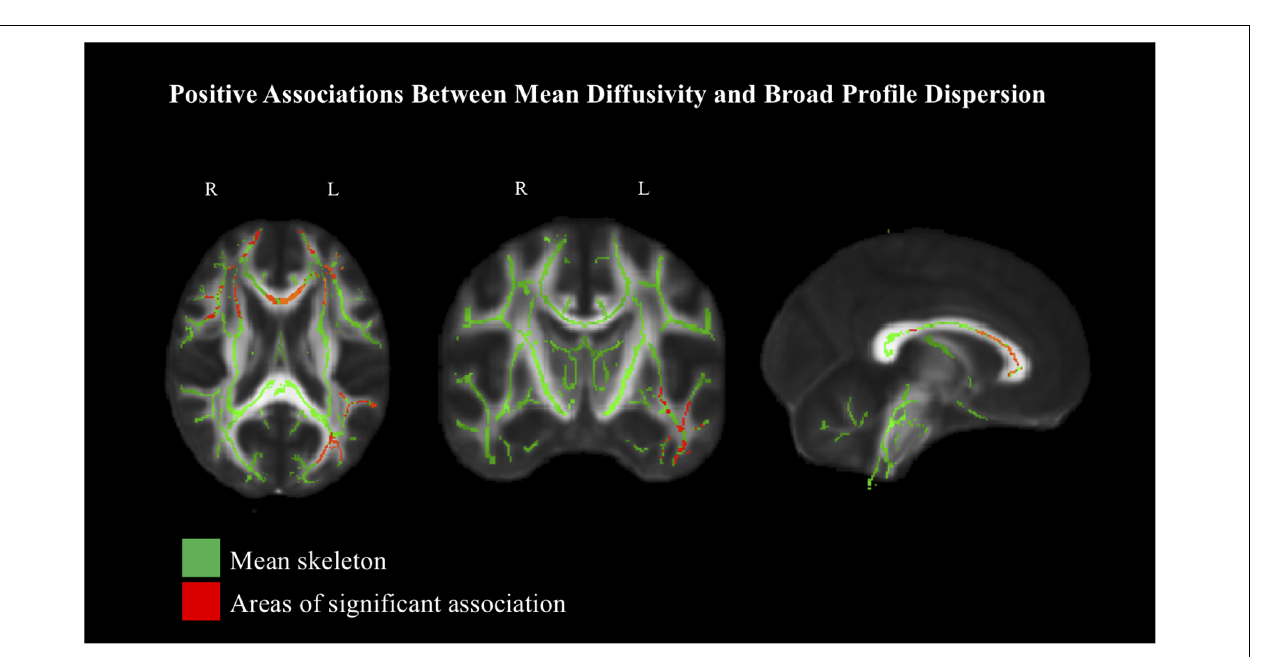
FIGURE 3 | Positive associations between intraindividual standard deviation (ISD)-BP and white matter, based on mean diffusivity (MD) at 90% threshold, depicted in radiological view. Mean FA skeleton shown in green. Areas of significant association shown in